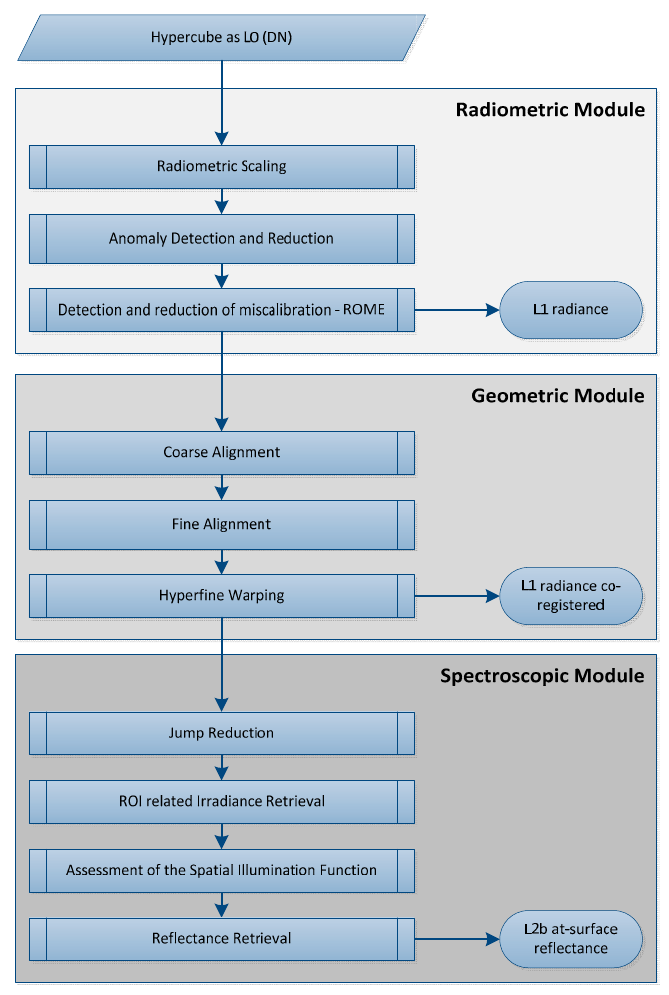
Figure 2. Processing scheme of the proposed approach GeoMAP-Trans.